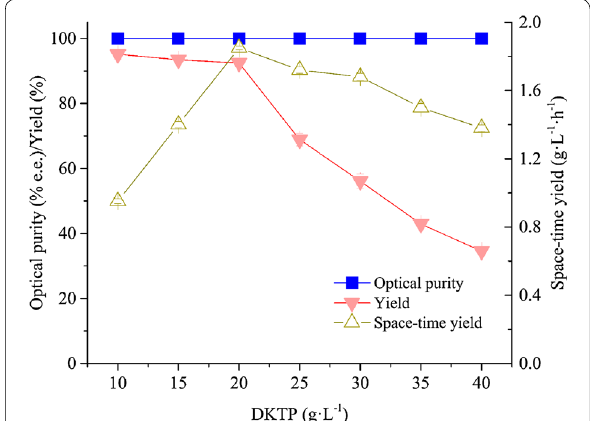
Fig. 5 Effect of DKTP concentration on CR2-L-GDH catalyzing asym- metric synthesis of ( S )-DHTP. All reactions were carried out in 10 mL TEA buffer (0.1 mol L − 1 , pH 8.4) comprising 10–50 g L − 1 DKTP with addition of 0.2 mmol L − 1 NADP + at 40 °C and 200 rpm for 12 h. The concentration of glucose added in the reaction was 10 folds of that of DKTP accordingly. All the results were the average of three parallel replicates